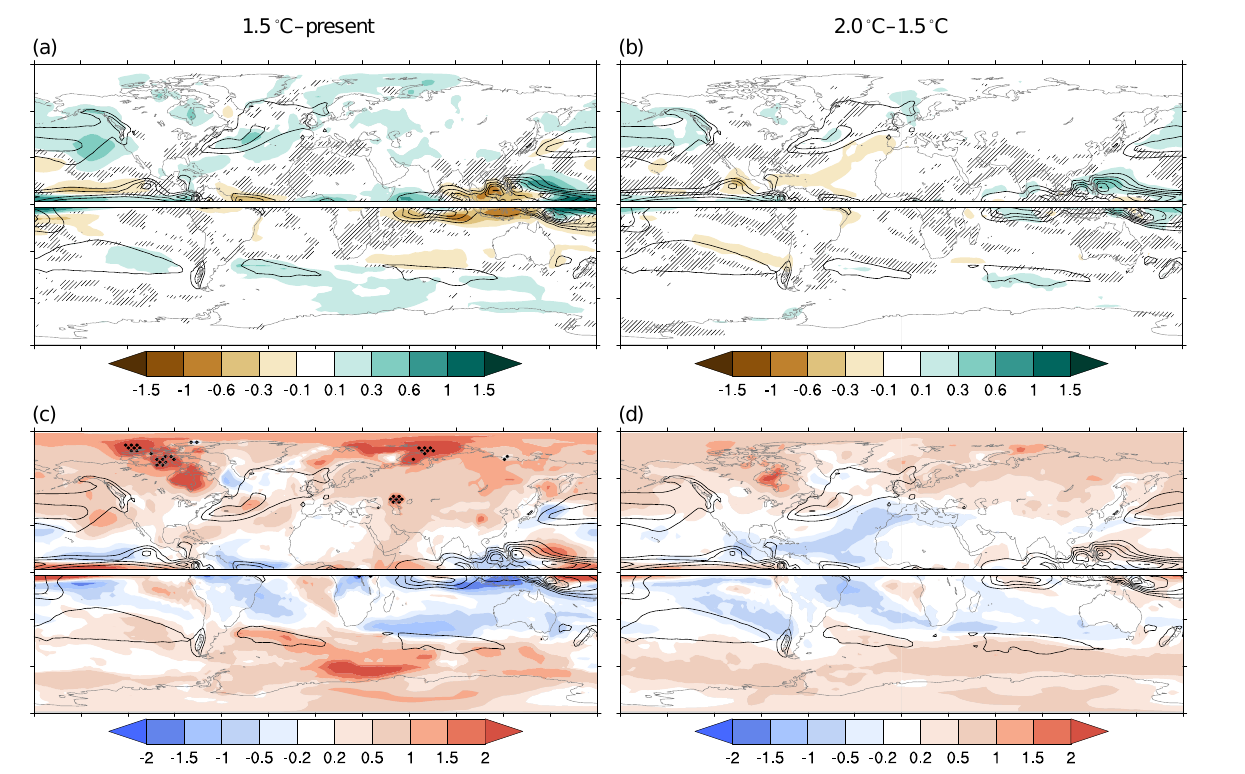
Figure 2. Multi-model mean response of winter (Northern Hemisphere DJF, Southern Hemisphere JJA) precipitation for 1.5 ◦ C–PD (a, c) and 2.0–1.5 ◦ C (b, d) . Panels (a) and (b) show responses (shading; units mmd − 1 ) along with the climatology (contour interval 2mmd − 1 starting from 4mmd − 1 ) for the (a) PD and (b) 1.5 ◦ C experiments. Panels (c) and (d) show signal-to-noise ratio β/σ , where the sign corresponds to the sign of the response, along with the climatology (contour interval 2mmd − 1 starting from 4mmd − 1 ) for the (c) 1.5 ◦ C and (d) 2.0 ◦ C experiments. In (a) and (b) , hatching masks out regions where there is no model consensus (fewer than four out of five models agree) on the sign of the response. In (c) and (d) , black dots mask out regions where the models do not agree on the magnitude of the response ( f 2 >